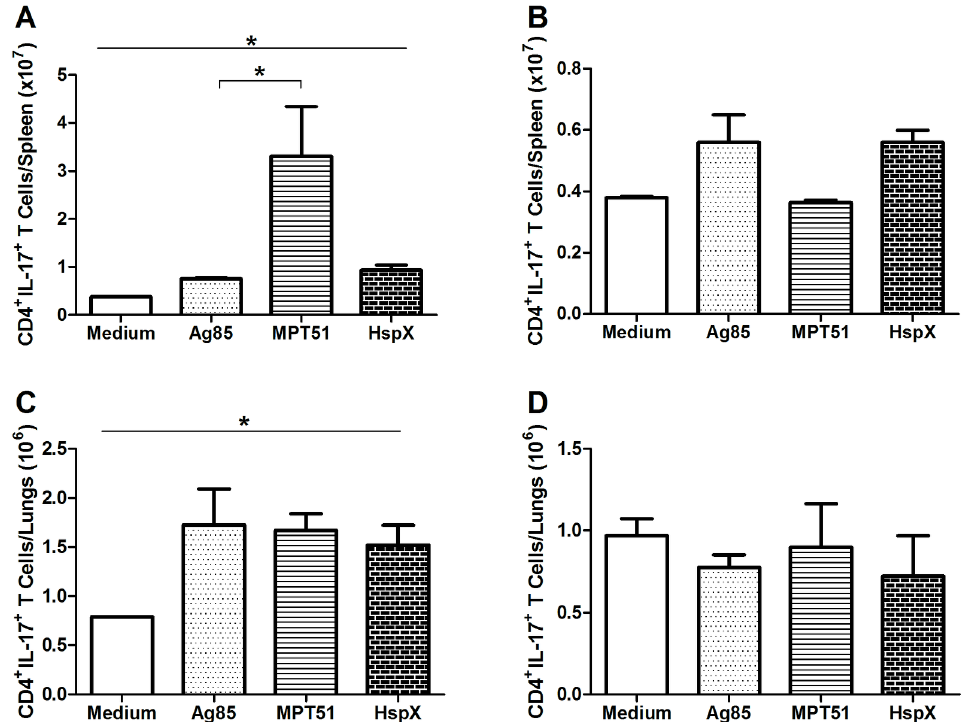
Figure 6. Levels of CD4 + IL-17 + T cells induced by exvivo stimulation with recombinant Ag85, MPT51, and HspX. Thirty days after vaccination, lung and spleen suspensions were stimulated ex vivo with Ag85, MPT51, HspX, or medium alone. The number of cells positive for CD4 and IL-17 was determined by flow cytometry. Lymphocytes were selected based on size and granularity. Gates were set to analyze CD4 + T cells, and then the fluorescence of antibodies detecting IL-17 + cells was recorded. (A–B) Spleen cells from mice vaccinated with (A) rBCG-CMX or (B) BCG. (C–D) Lung cells from mice vaccinated with (C) rBCG-CMX or (D) BCG. In A and C, all results were different from the medium stimulation. These data are representative of two independent experiments (N=6, *p ,